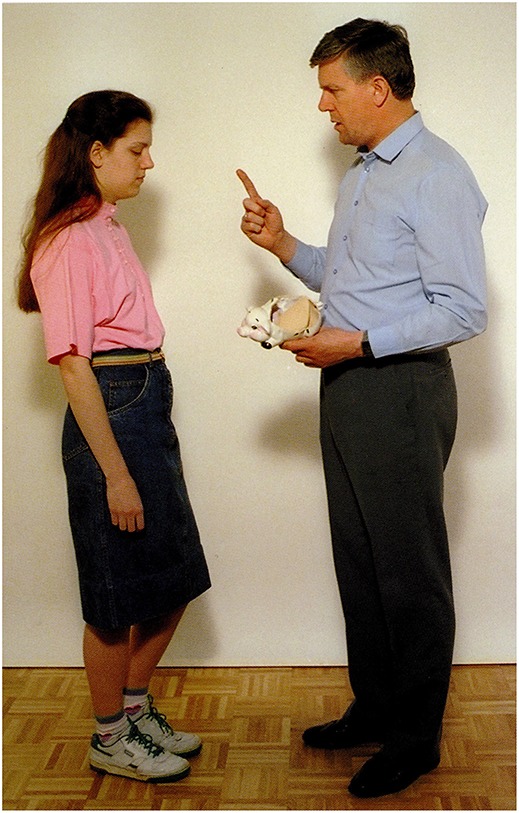
A man scolds a girl (for breaking the piggy bank) (Stark, 1998).